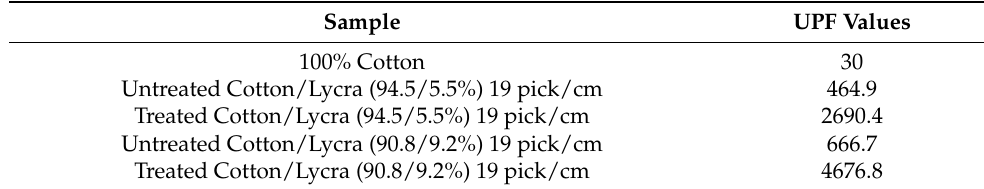
Table 4. UPF Values of the Blank and SiO 2 NP-Cotton/Lycra Composites.